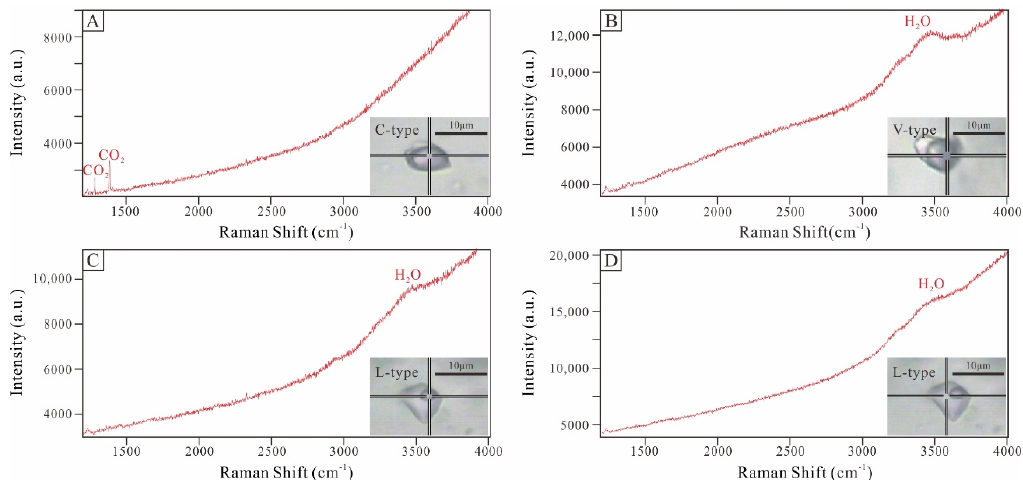
Figure 7. Representative laser Raman spectra for different types of FIs from the Huoluotai Cu (Mo) deposit. ( A ) The vapor phases of C-type FIs in stage I are rich in CO 2 ; ( B ) The vapor phases of V-type FIs are almost entirely H 2 O; ( C ) The vapor phases of L-type FIs are almost entirely H 2 O; ( D ) The liquid phases of L-type FIs are almost entirely H 2